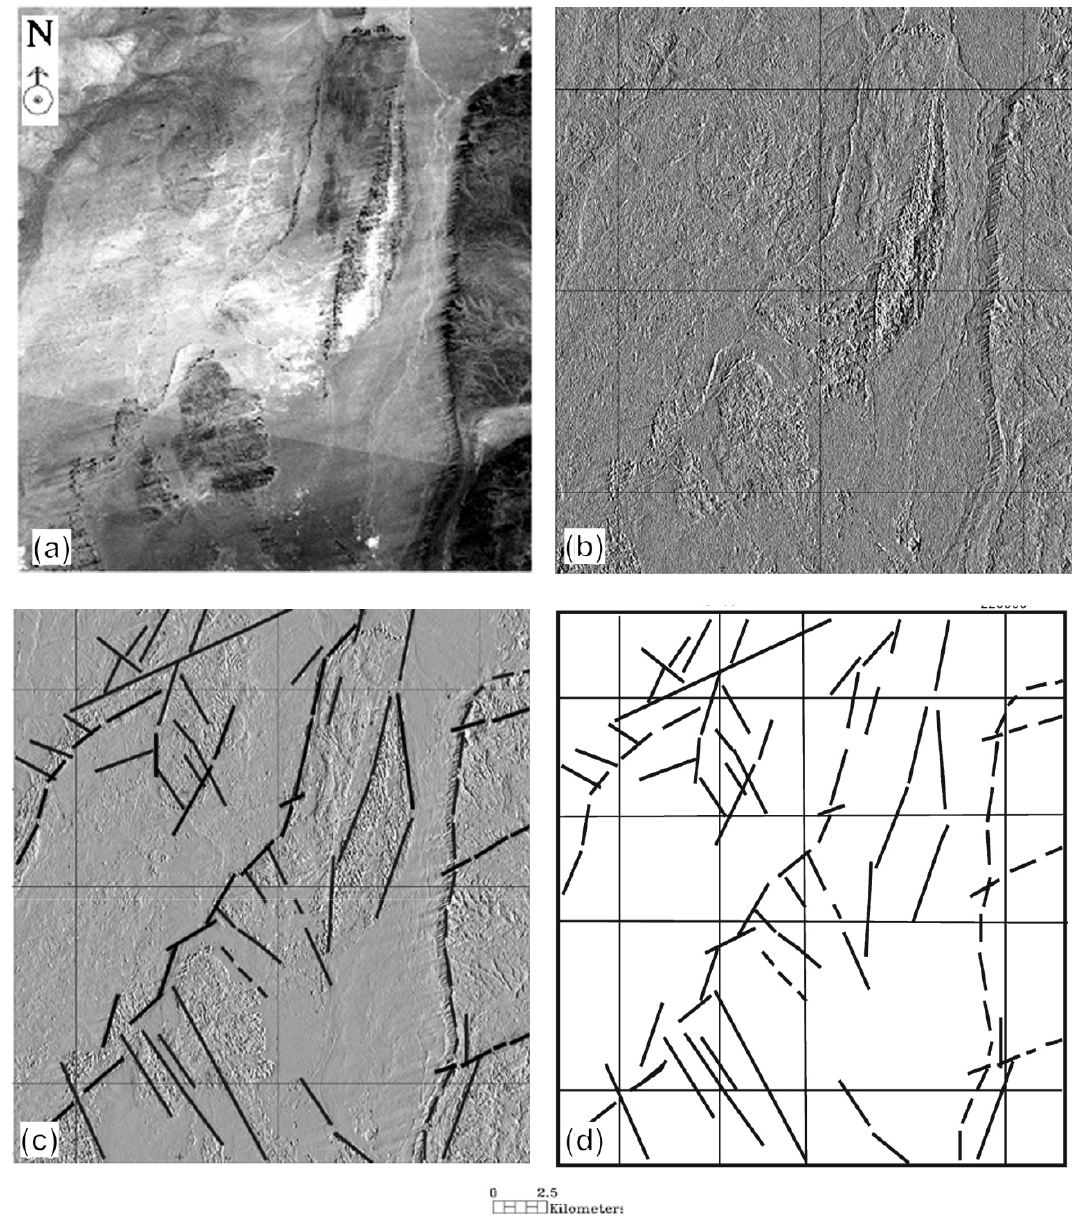
Figure 8. Application of Prewitt filtering on Landsat 7 ETM+ over the Central Hoggar, South Algeria derived from [98]; ( a ) PC1 of multispectral bands of Landsat 7ETM+ subjected as input of filtering, ( b ) overlayed resultant Prewitt filtered images of four directions, ( c ) digitized lineaments from the filtered image, and ( d ) final extracted lineaments.